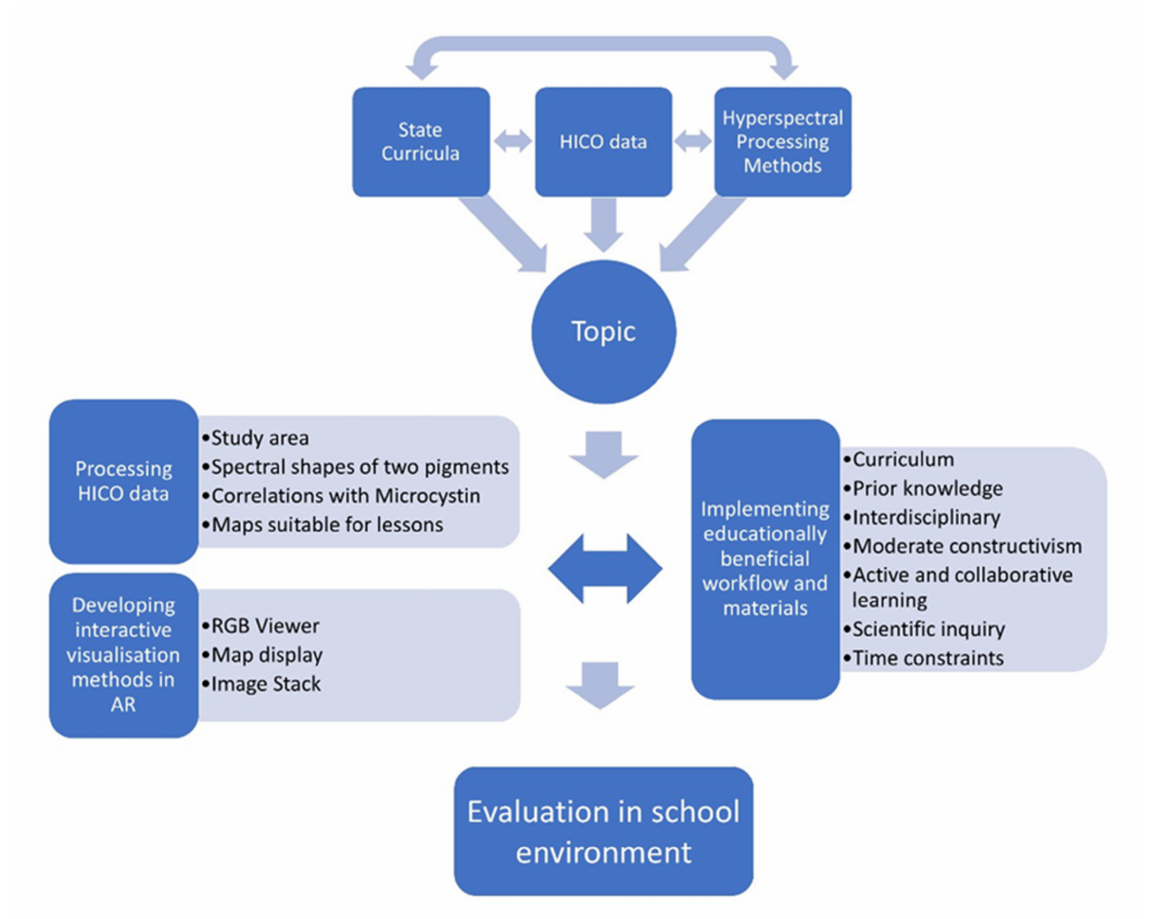
Figure 1. Workflow of the